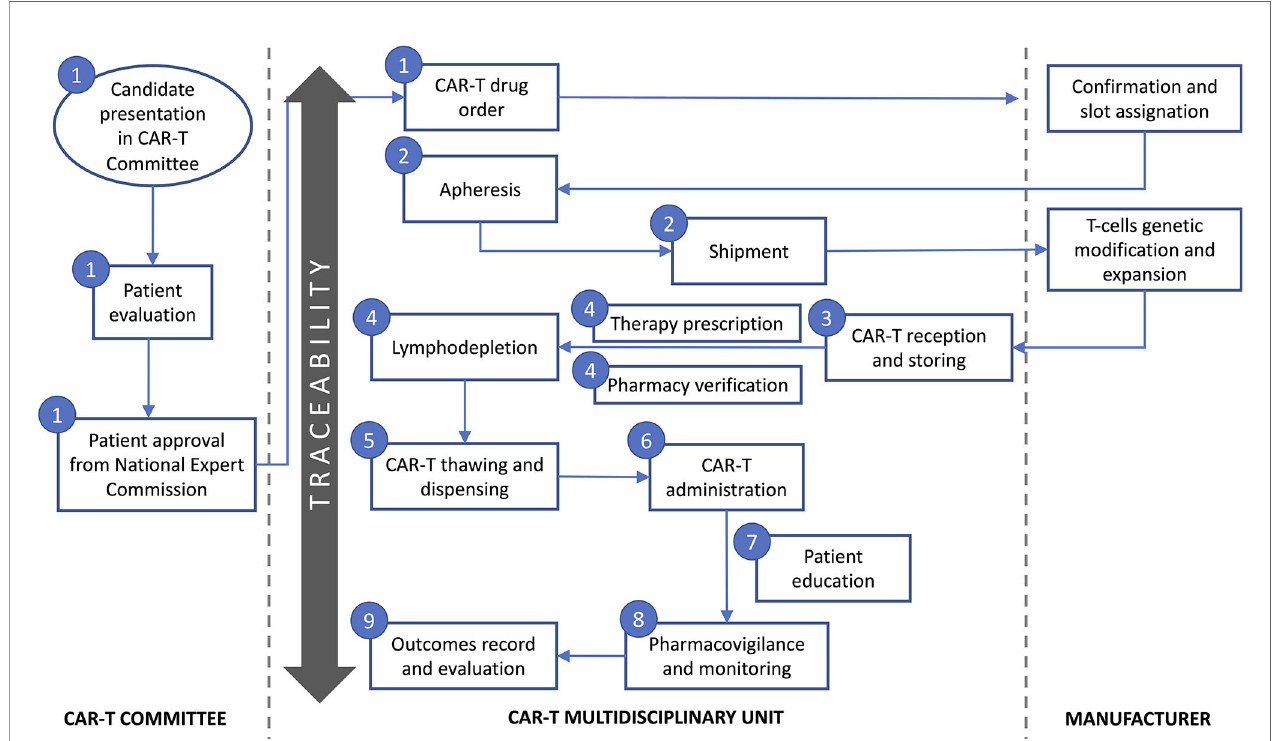
FIGURE 1 | Key tasks during CAR-T cell therapy use process de fi ned by the multidisciplinary team. Numbers represent the guide key points de fi ned in subheading 3 in the text: 1-Patient evaluation and selection and CAR-T cell drug order; 2-Apheresis and material shipment; 3-Reception of CAR-T cell drug and storing; 4-CAR- T cell drug prescription and pharmacy veri fi cation of orders; 5-CAR-T cell drug thawing and dispensing; 6-CAR-T cell drug administration; 7-Patient information and education; 8-Pharmacovigilance and monitoring; 9-Outcomes ’ record and